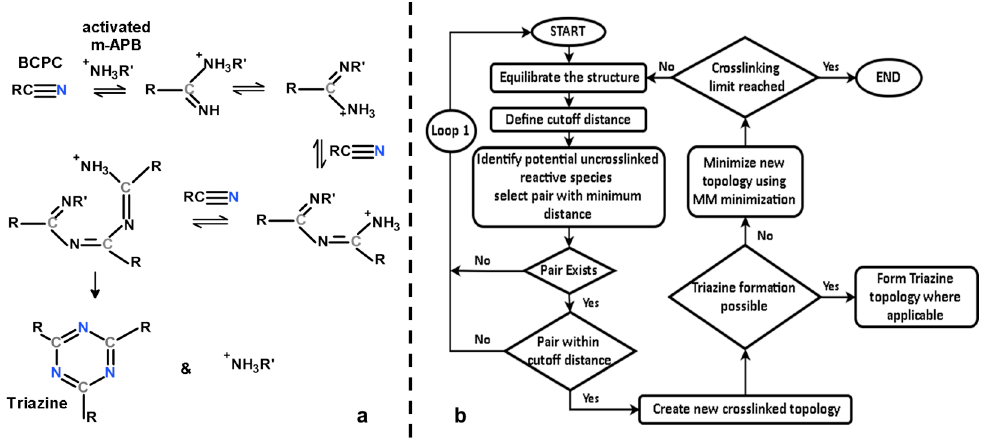
Figure 3. ( a ) Cross-linking reactions leading up to triazine formation; ( b ) cross-linking algorithm.